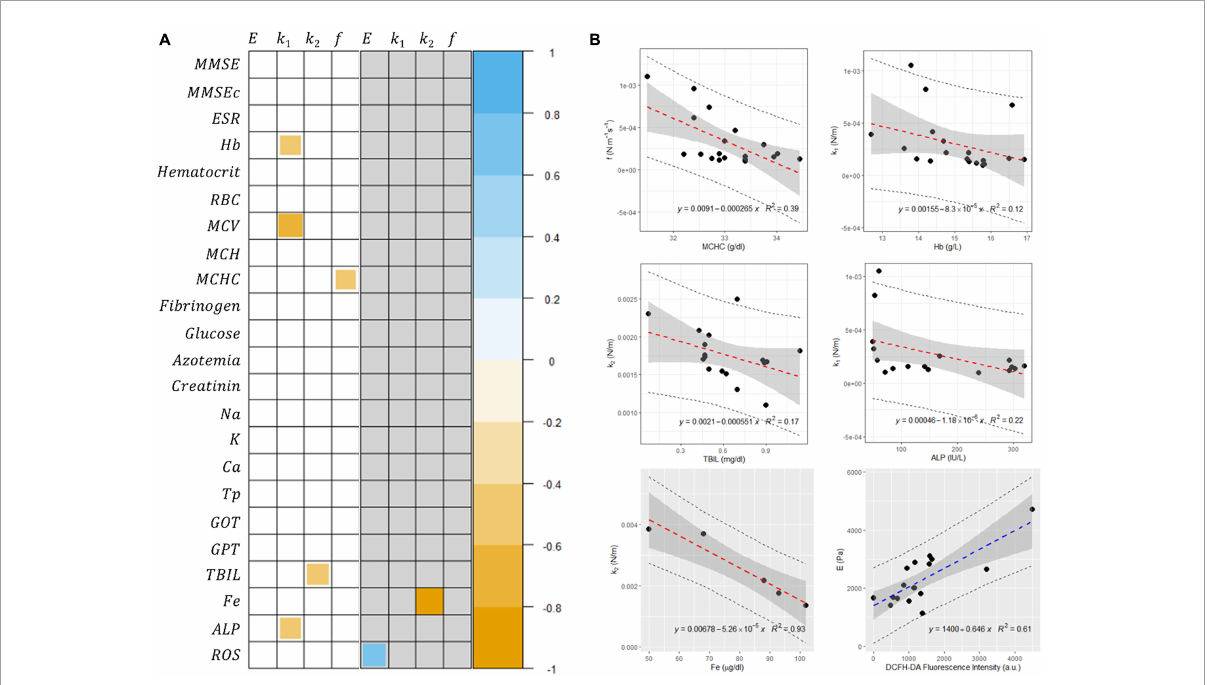
FIGURE5 (A) Spearman correlation matrix between selected hematological parameters and mechanical biomarkers. Correlation maps are shown separately for control subjects (white background) and patients with Alzheimer’s disease (AD) (gray background). The two maps show only the statistically significant correlations (significance level 0.05). (B) Scatter plots showing the relationship between selected variables together with the corresponding linear regression